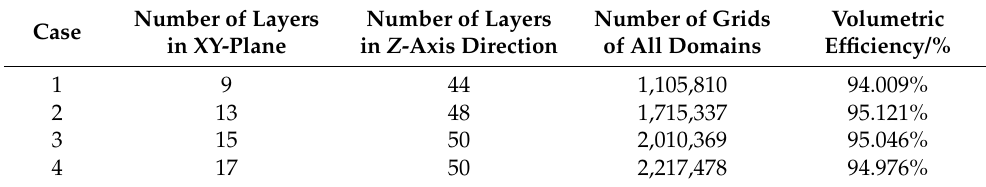
Table 3. Grid independence